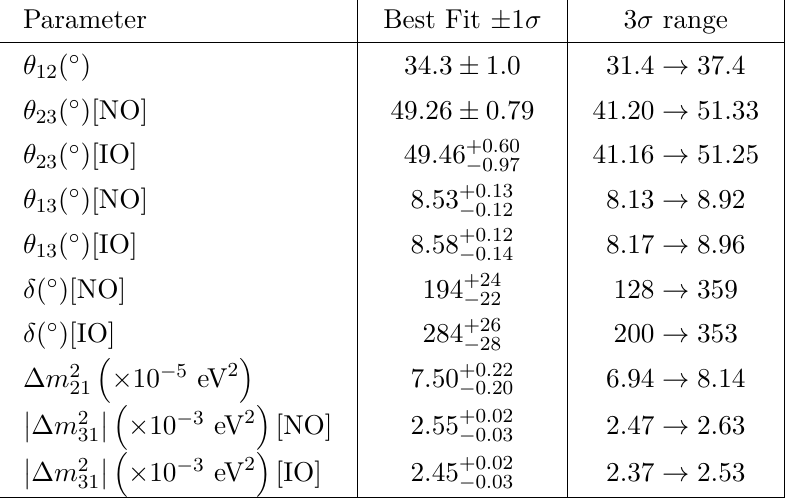
Table 2 . Current allowed intervals for the lepton mixing angles, neutrino mass-squared differences and the Dirac phase δ obtained from the global fit of neutrino oscillation data performed in ref. [3] (see also refs. [4] and